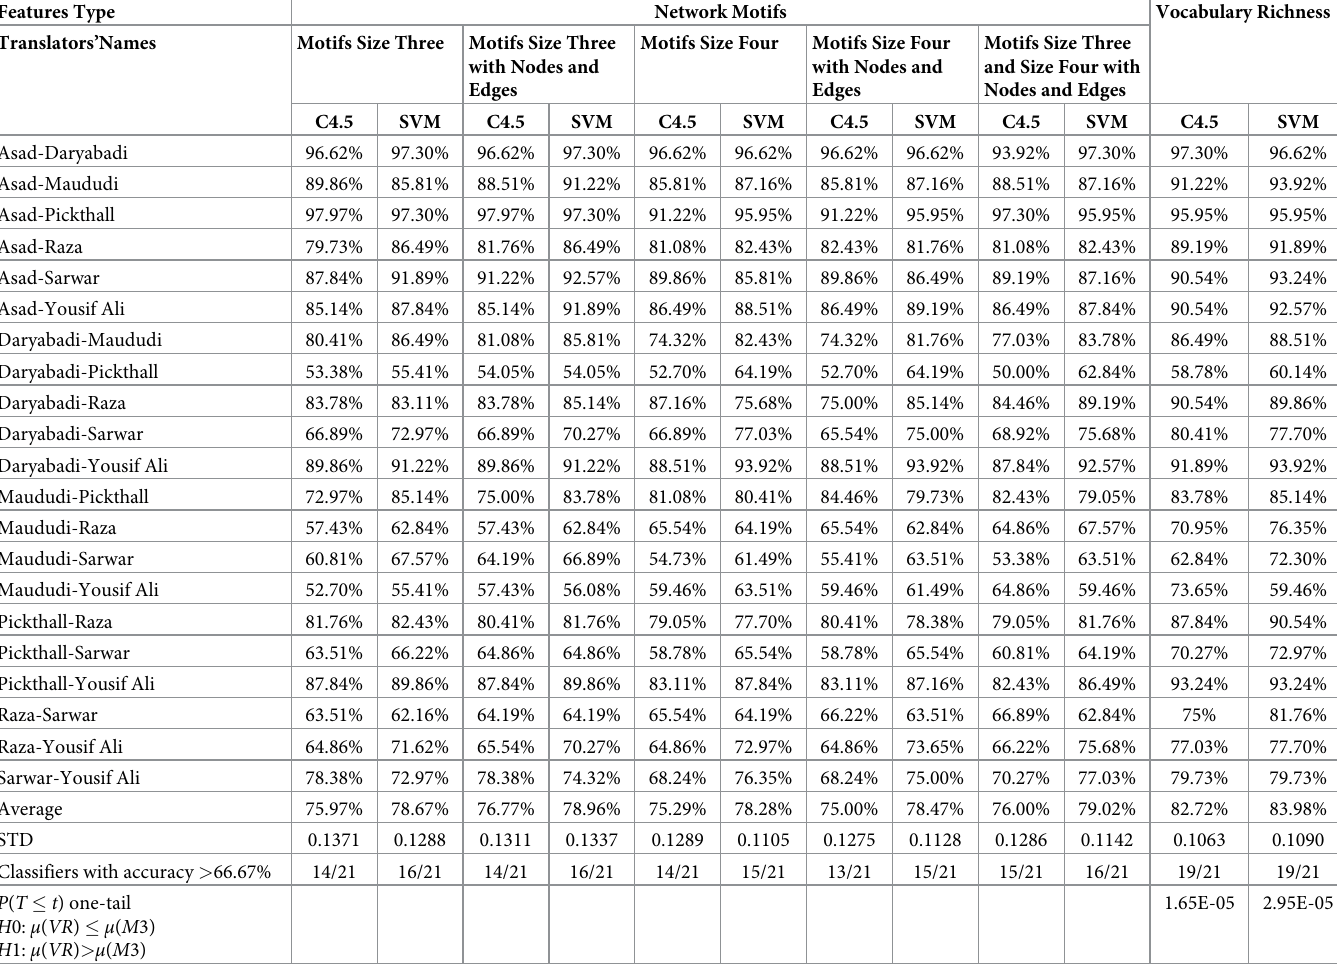
Table 11. Classification results for applying ranking to motifs of size three and size four, and vocabulary richness as translator stylometry features for the 1st